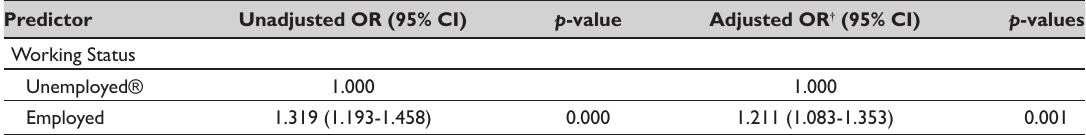
Table 3: Logistic regression analysis between contraceptive use and both employment status and other sociodemographic